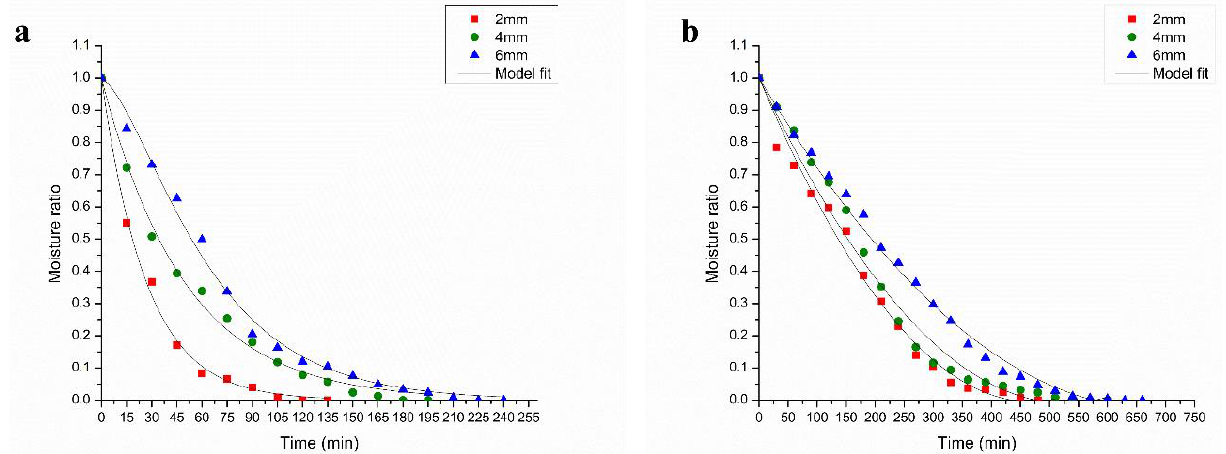
Figure 3. Moisture ratio vs time with best-fit model line: ( a ) RW dryer and ( b ) convective dryer. Table 1. Mathematical models used to predict the moisture ratio values and regression coefficients with statistical parameters of RW-dried